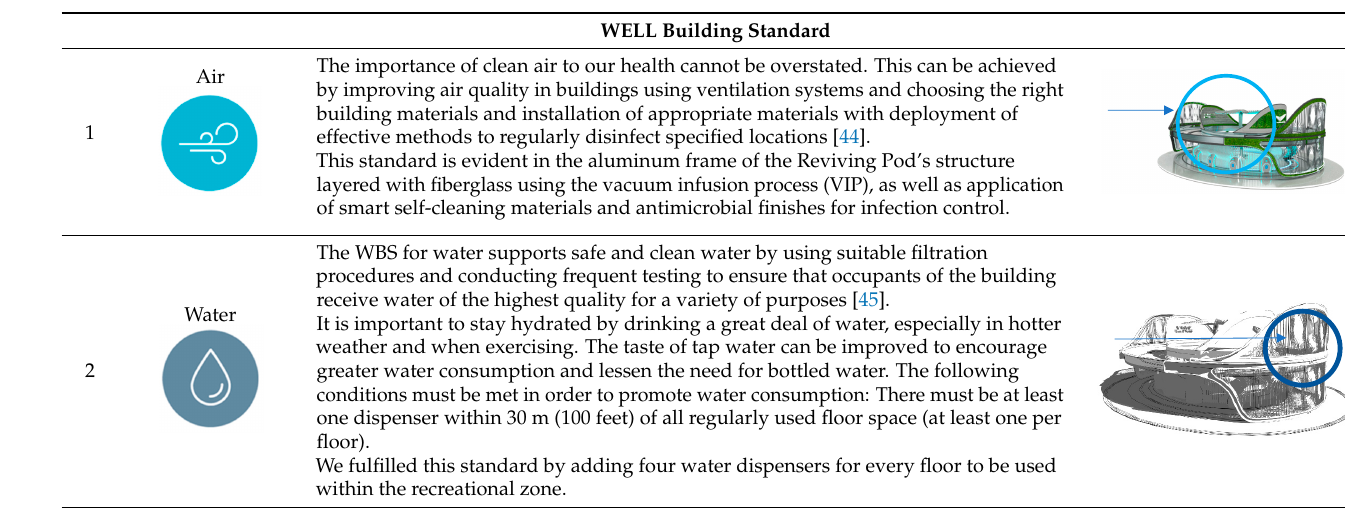
Figure 18. ( a ) Right side elevation; ( b ) right side section (designed by the authors). Table 1. This table shows the WELL Building Standard features applied to the recreational zone and Reviving